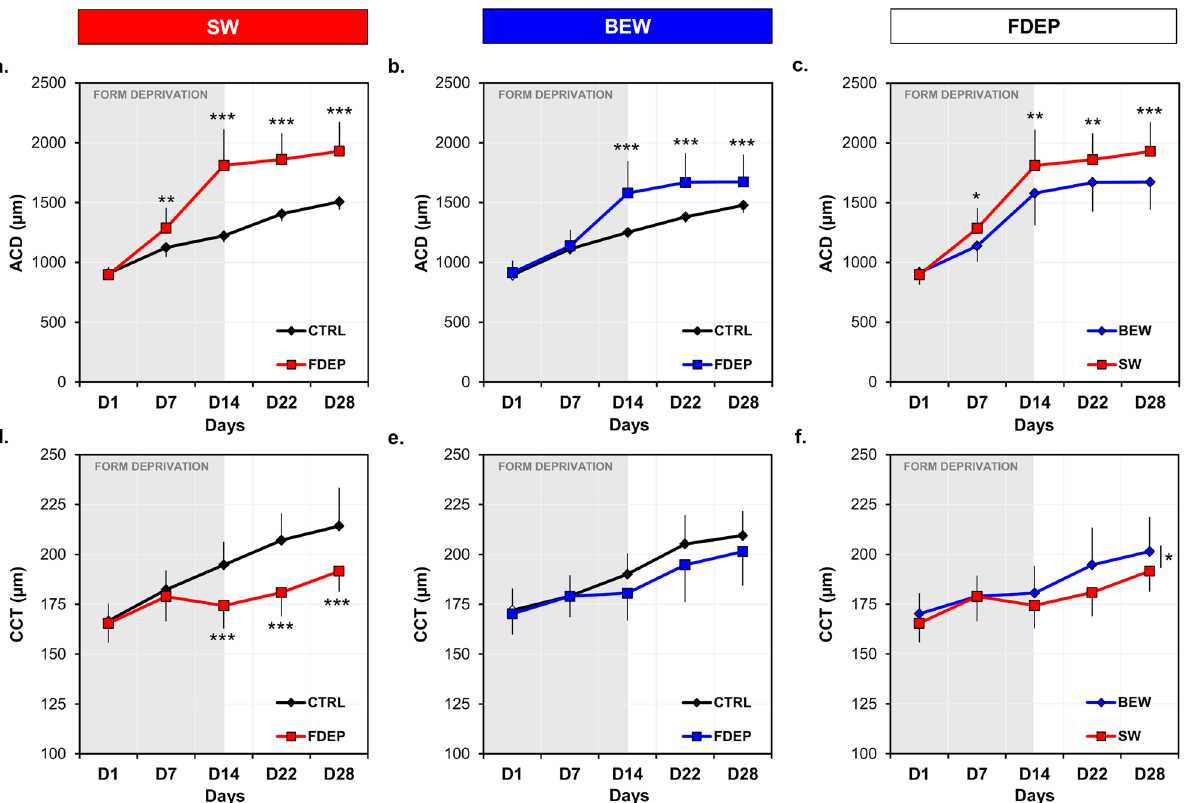
Figure 5. Anterior chamber depth and central corneal thicknesses in FDEP and control eyes under SW and BEW lights. ACD of FDEP eyes were increased compared to control eyes under both lighting conditions ( a , b ); however, FDEP eyes reared under BEW showed a reduced ACD compared to FDEP eyes reared under SW light ( c ). CCT of FDEP eyes were reduced under SW light ( d ) but not under BEW light ( e ), compared to control eyes. The CCT of FDEP eyes was reduced under SW light compared to BEW light ( F (1, 34) = 5.23, P = 0.03) ( f ). Data are represented as average ± SD. Post hoc pairwise comparison: *P < 0.05; ** P < 0.01; *** P < 0.001.